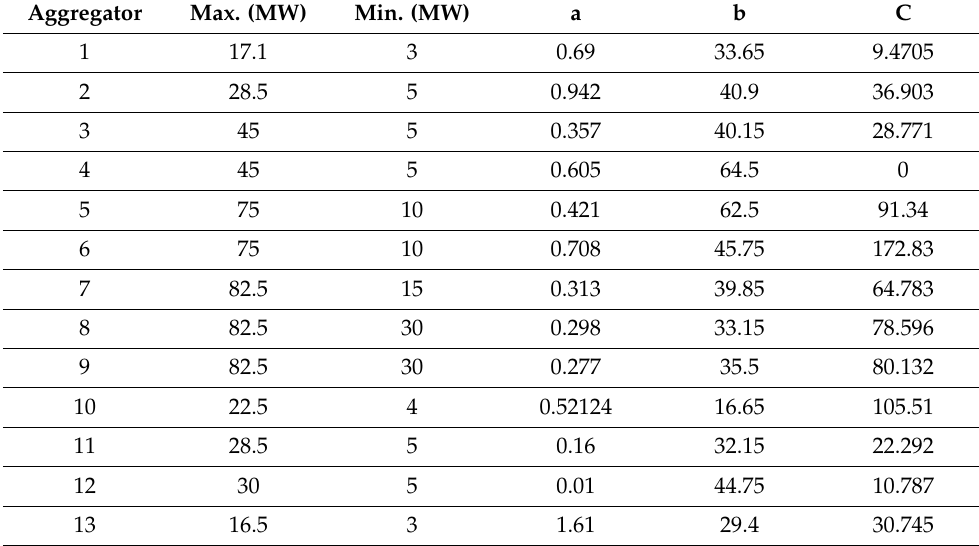
Table 4. Bidding curve of user aggregators.